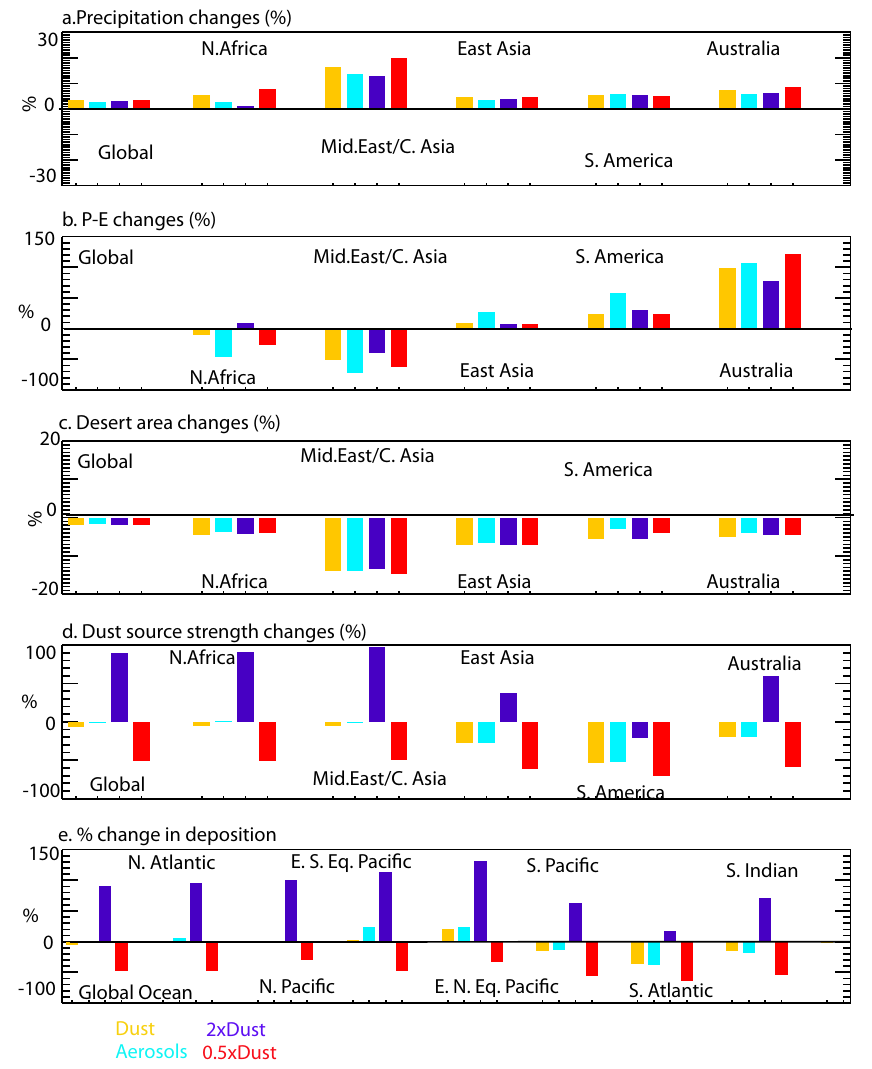
Fig. 14. Percent changes in source areas (a) , precipitation (b) , precipitation minus evaporation (c) , desert area (d) , dust source strength (e) and deposition in ocean basins (e) for 2080–2099 compared to preindustrial control for the different cases. Eastern S. Eq. Pacific is defined as 220E–280E, 20S–0N; eastern N. Eq. Pacific is defined as 220E–280E,